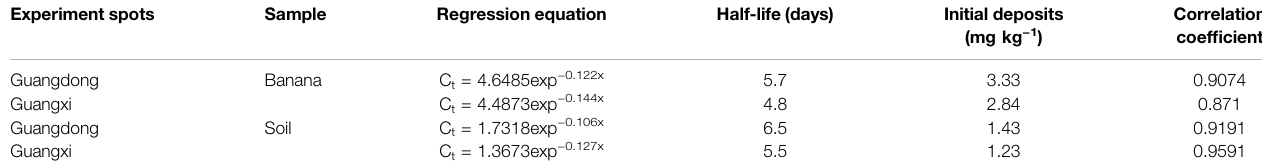
TABLE 2 | Dissipation dynamics parameters of kresoxim-methyl in banana and soil. Experiment spots